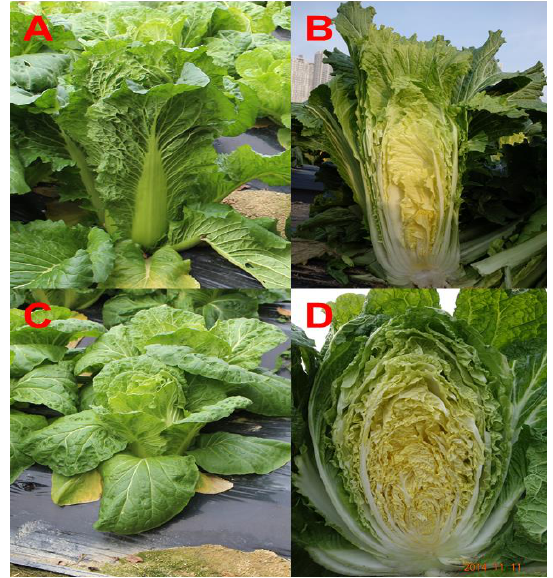
Figure 1. Two different phenotypes of Chinese cabbage. ( A ) Rectangular Chinese cabbage; ( B ) longitudinal section of the rectangular Chinese cabbage; ( C ) oval Chinese cabbage; ( D ) longitudinal section of the oval Chinese cabbage.